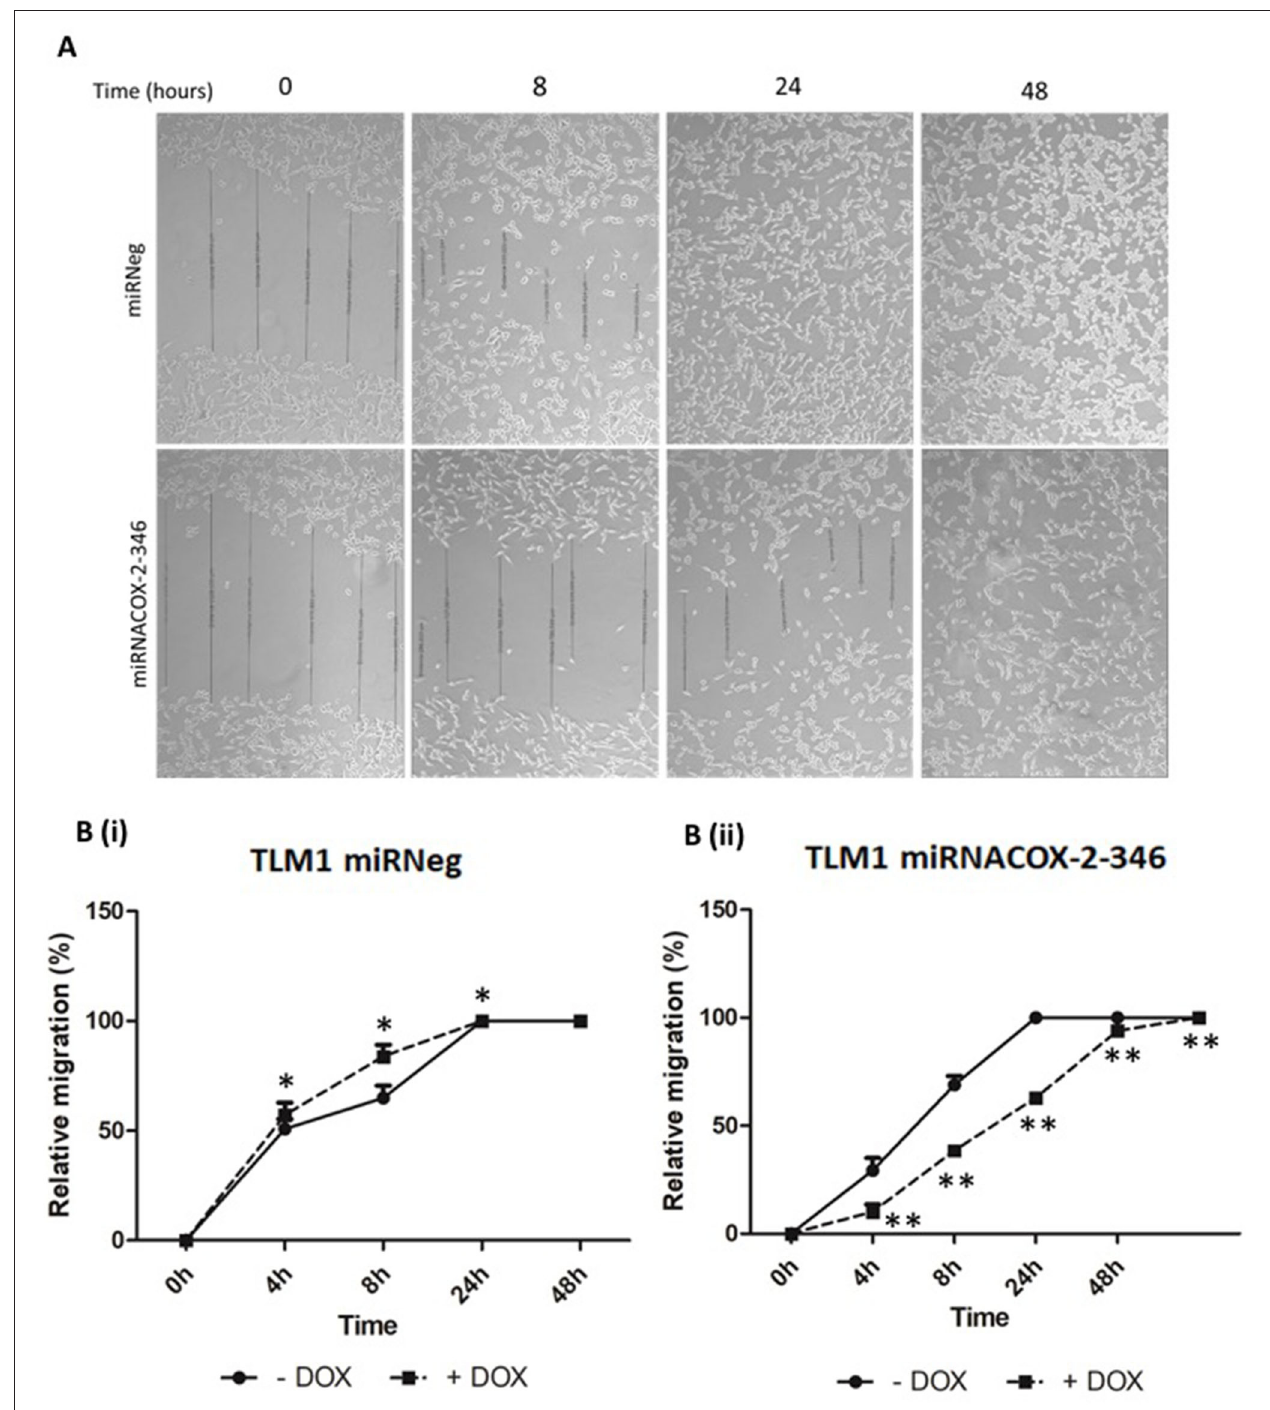
FIGURE 5 | Migration of canine melanoma cells is COX-2 dependent. (A) Representative image of a scratch assay of TML1 cells transfected with either miRNACOX2-346 or the miRneg negative control, treated with 1 µ g/ml DOX. After 24h incubation a scratch was made and the gap distance was measured at regular intervals until the gap closed. (B) Quantification of this data (i) miRneg negative control and (ii) miRNACOX2-346 ( p < 0.05*, p <